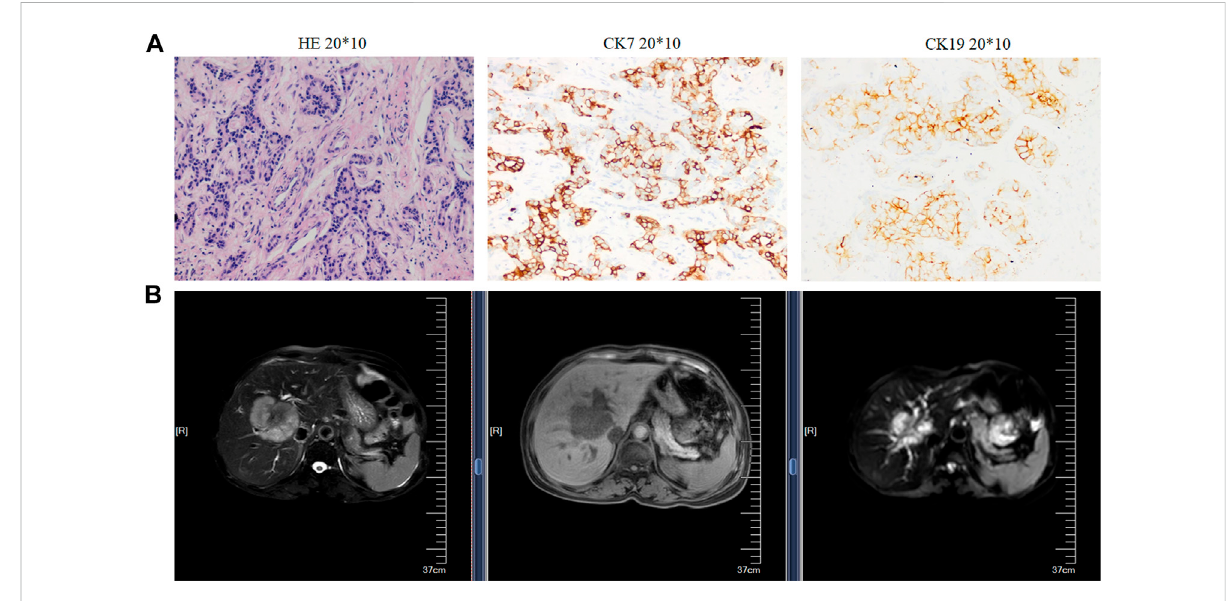
FIGURE 1 Histopathological and radiographic analysis. (A) Hematoxylin and eosin (HE) staining (left), the immunohistochemical images, and expression rate of CK7 (middle) and CK19 (right). (B)